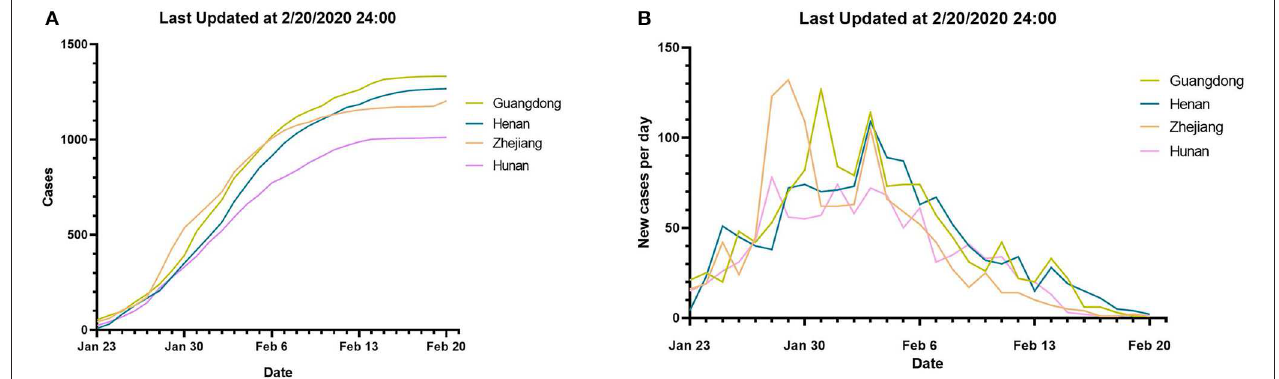
FIGURE 4 | Changes in confirmed cases in four provinces of Guangdong, Henan, Zhejiang, and Hunan province; data between January 23, 2020 at 24 p.m. and February 20, 2020 at 24 p.m. (Beijing time), (A) the total number of confirmed COVID-19 cases in Zhejiang, Guangdong, Henan, and Hunan province. (B) The number of daily increased confirmed COVID-19 cases in Guangdong, Henan, Zhejiang, and Hunan province.